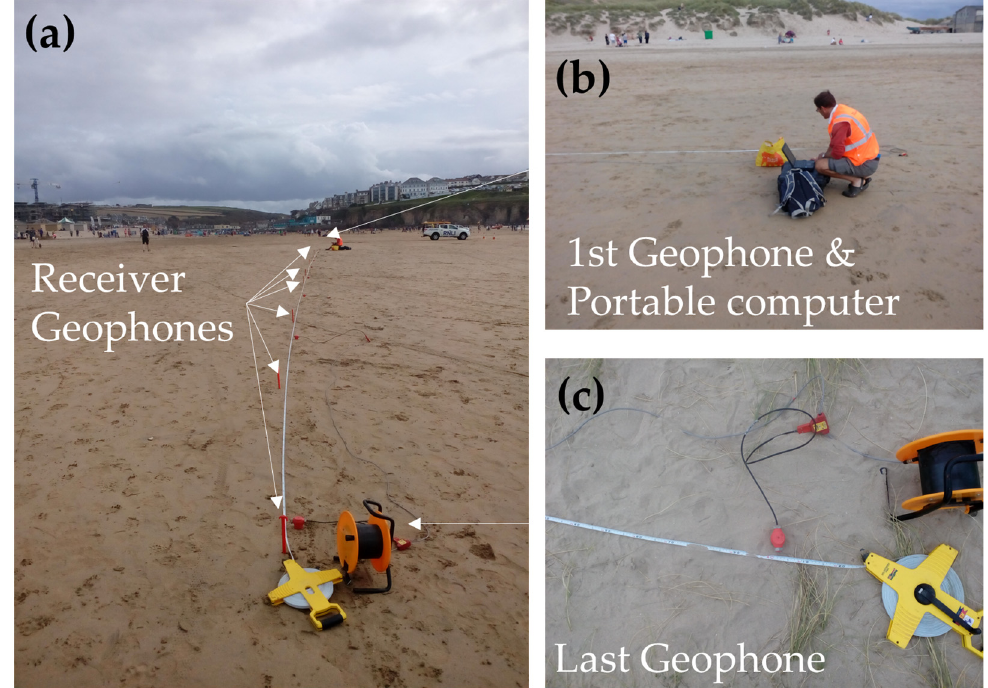
Figure 4. Photos (source BGS) illustrating a typical MASW field configuration showing the chain of receiver geophones ( a ) and details of first ( b ) and last geophone ( c